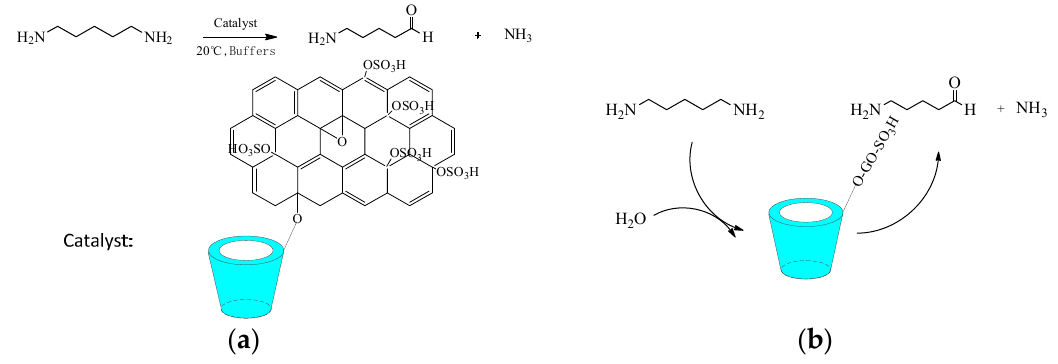
Scheme 3. ( a ) The oxidation reaction of cadaverine catalyzed by β -CD/GO-SO 3 H–GCE; ( b ) the proposed mechanism of the oxidation of cadaverine.